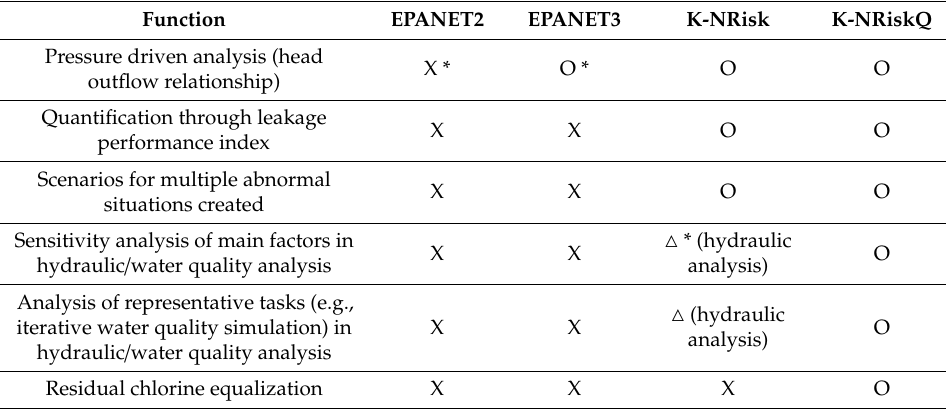
Table 1. Function comparison between major hydraulic / water-quality analysis